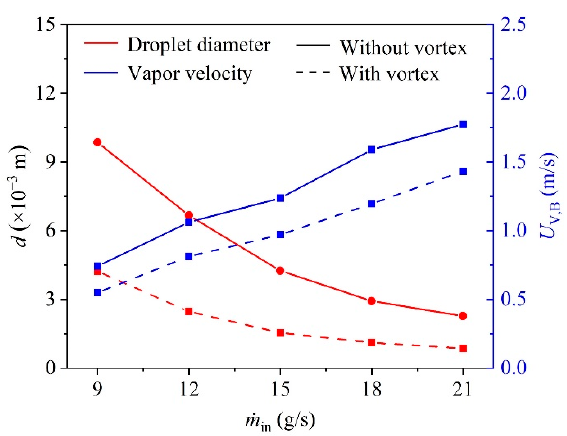
Figure 9. Droplet diameter and the vapor velocity in the branch outlet under various ṁ in.